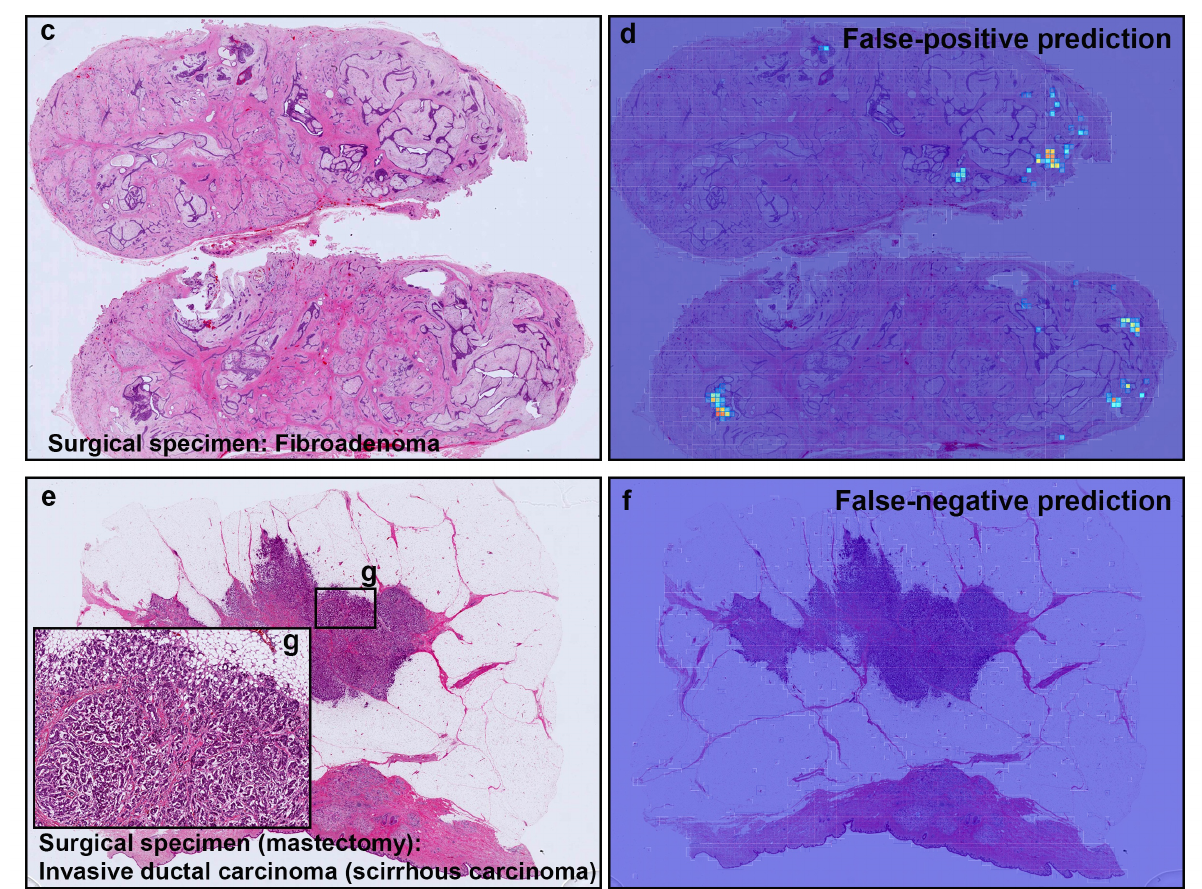
Figure 7. Representative true positive, false positive, and false negative prediction outputs on surgically resected specimens for invasive ductal carcinomas (IDCs) and fibroadenoma. Histopathologically, ( a ) has IDC; ( c ) is fibroadenoma; and ( e ) has IDC (scirrhous type); ( b ) shows true positive probability heatmap using transfer learning from ImageNet model (magnification × 10) for IDC invading area which was corresponded to surgical pathologists marked area with blue-ink-dots (and yellow-triangles) ( a ); ( d ) exhibited false positive prediction of IDC in fibroadenoma. There are no true positive predictions of IDC cells on heatmap image ( f ) in scirrhous carcinoma of IDC ( e ).